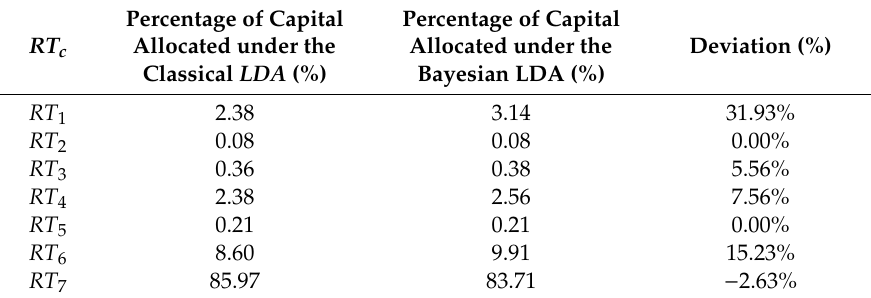
Table 13. Capital allocation through historical and Bayesian